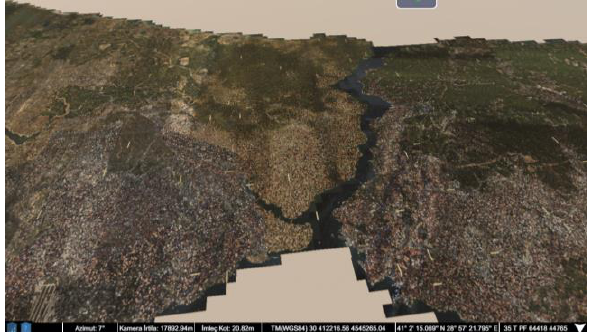
Figure 2. The study area build up part of Istanbul province.